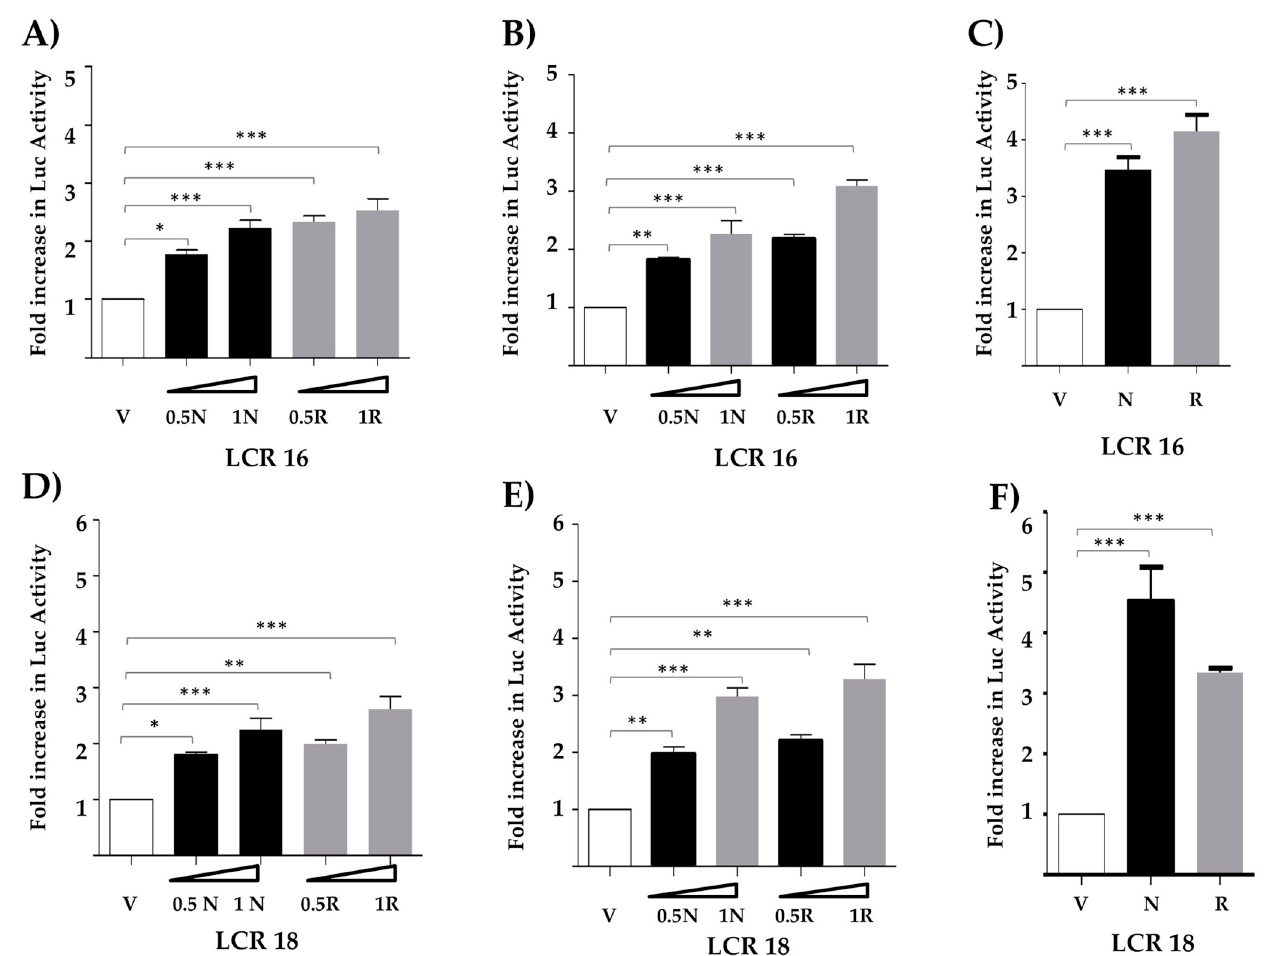
Figure 1. Nanog increases the transcriptional activity of HPV16/18 LCRs in different transformed cell lines. Three different transformed cells lines were used: TC-1 ( A , D ); C-33A ( B , E ); and HEK-293T ( C , F ) were transfected with reporter vectors containing the HPV16 LCR (LCR16) or HPV18 LCR (LCR18), respectively, driving the expression of the luciferase gene, and co-transfected with empty vector (V); Nanog (N); or H-Ras V12 (R), as a positive control. Different amounts of N and R vectors (0.5 μ g and 1 μ g) were used in the case of TC-1 and C-33A cells. Luciferase reporter activity was measured 48 h post-transfection. The standard error of the mean of three independent experiments, in triplicate, is depicted in the graph. One-way ANOVA test with a Tukey analysis was performed to evaluate the significant differences. * p ≤ 0.05, ** p ≤ 0.01, *** p ≤ 0.001.